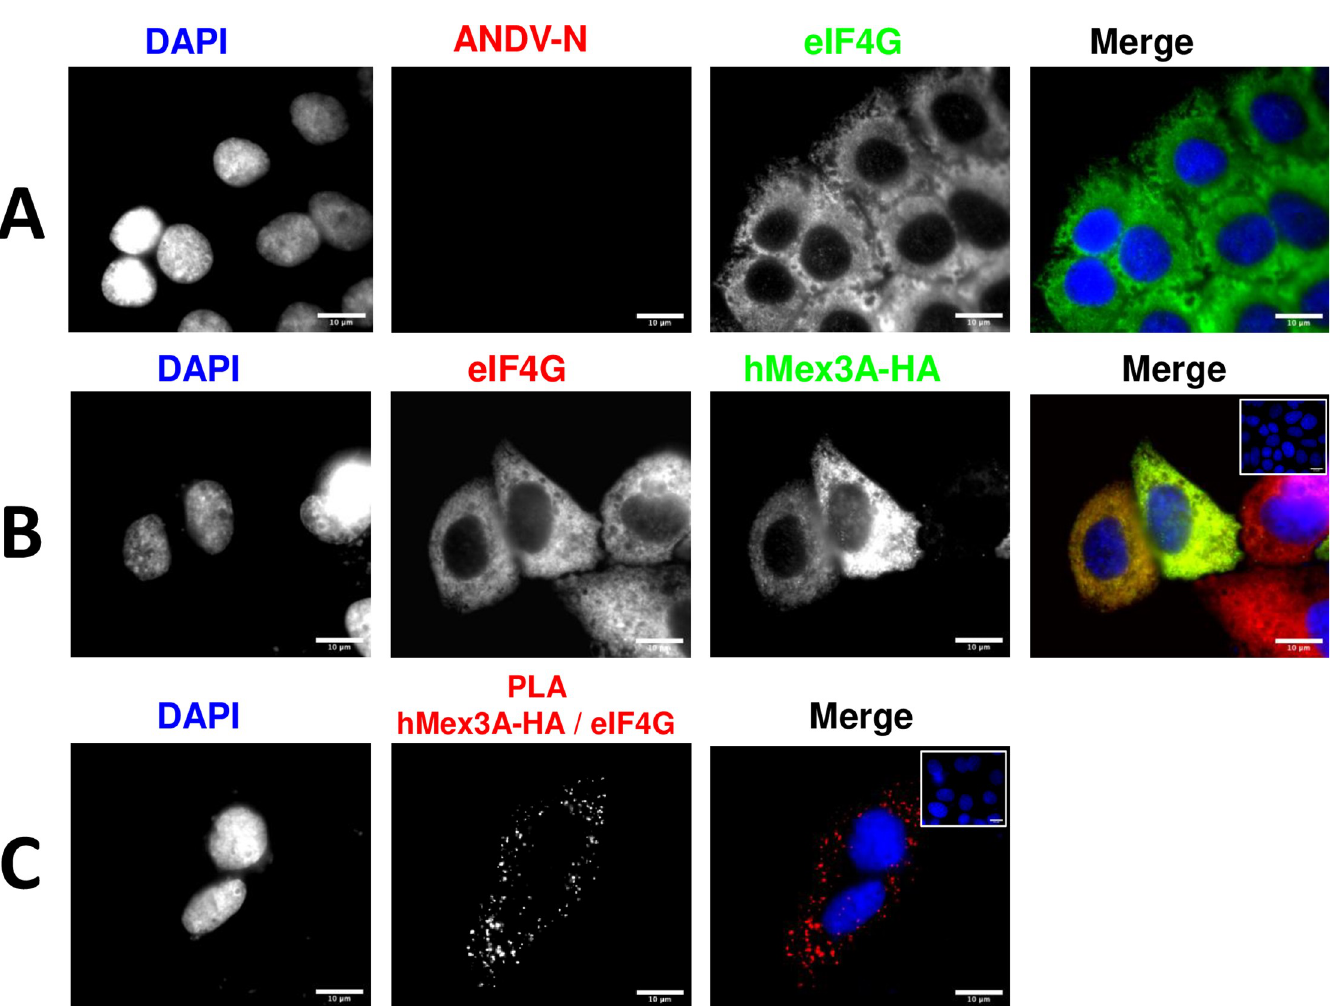
Fig 10. The hMex3A protein interacts with eIF4G in Huh-7 cells. Huh-7 cells were transfected with a plasmid encoding for the hMex3A-HA protein, and 24 hpt they were fixed using (PFA 4%) and permeabilized (PBS-Triton). (A) ANDV-N and the endogenous eIF4G proteins were detected by IF using a mouse monoclonal anti- ANDV-N or a rabbit polyclonal anti-eIF4G antibody as primary, and a donkey anti-mouse Alexa 594 or an Alexa 488 donkey anti-rabbit as the secondary antibodies. (B) The hMex3A-HA and the endogenous eIF4G proteins were detected by IF using mouse monoclonal anti-HA or a rabbit polyclonal anti-eIF4G as primary antibodies. As for secondary antibodies, a donkey anti-mouse Alexa 488 or a donkey anti-rabbit Alexa 594 were used. As a negative control of the IF, the inset in the upper right corner of the merge shows cells incubated only with secondary antibodies. (C) hMex3A-HA expressing Huh-7cells incubated with primary antibodies as in (B), but PLA secondary antibodies were used following the manufacturer’s instructions. As a negative control of the PLA, the inset in the upper right corner of the merge shows cells incubated only with the PLA secondary antibodies. (A-C) Vectashield with DAPI was used as mounting media. The images were obtained in Olympus epifluorescence Microscopy and processed by Image